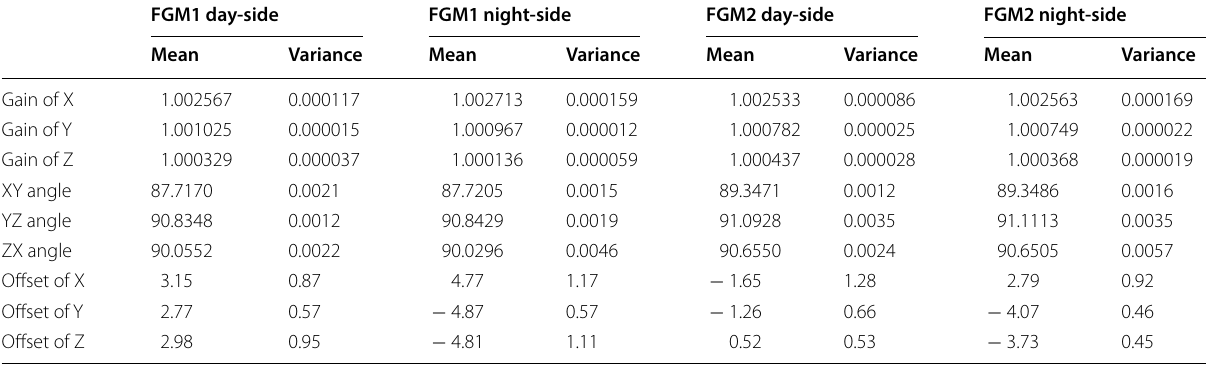
Table 2 The sensor parameter mean values and variances from March 7th, 2018 to November 15th, 2018